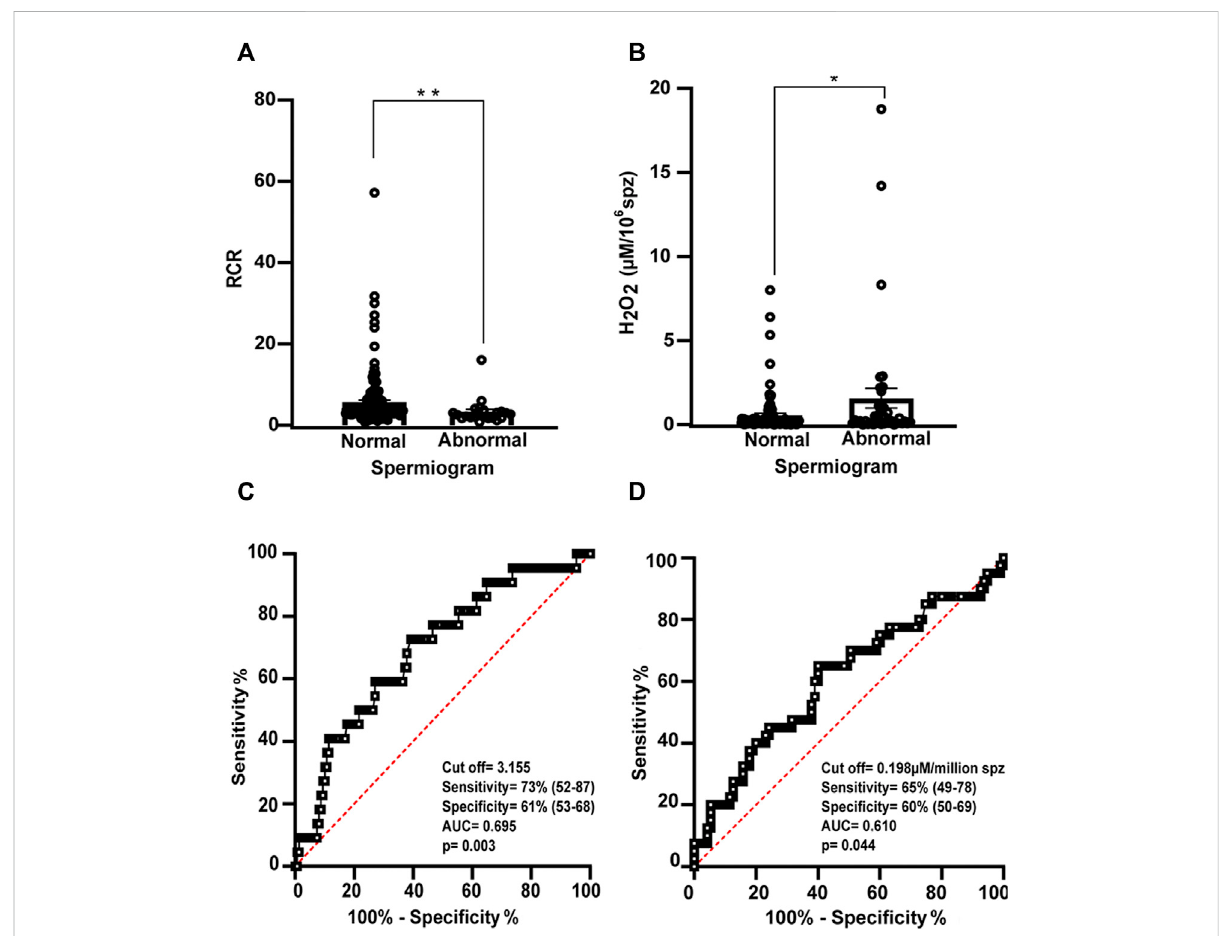
FIGURE 6 Relation between RCR and hydrogen peroxide concentration and spermogram parameters. Bars represent the mean values of (A) RCR (normal N = 148; abnormal N = 23) and (B) extracellular H N = 95; abnormal N = 40) ± SEM. A Mann-Witney test was used to 2 O 2 concentration (normal evaluate statistical signi fi cance. * p < 0.05, ** p < 0.01 (C) Receiver operating characteristic (ROC) curve showing RCR cut off value, sensitivity (%), speci fi city (%), and area under the curve for normal and abnormal spermiogram and (D) (ROC) curve showing [H 2 O 2 ] cut off value (µM/million sperm), sensitivity (%), speci fi city (%), and area under the curve for abnormal and normal